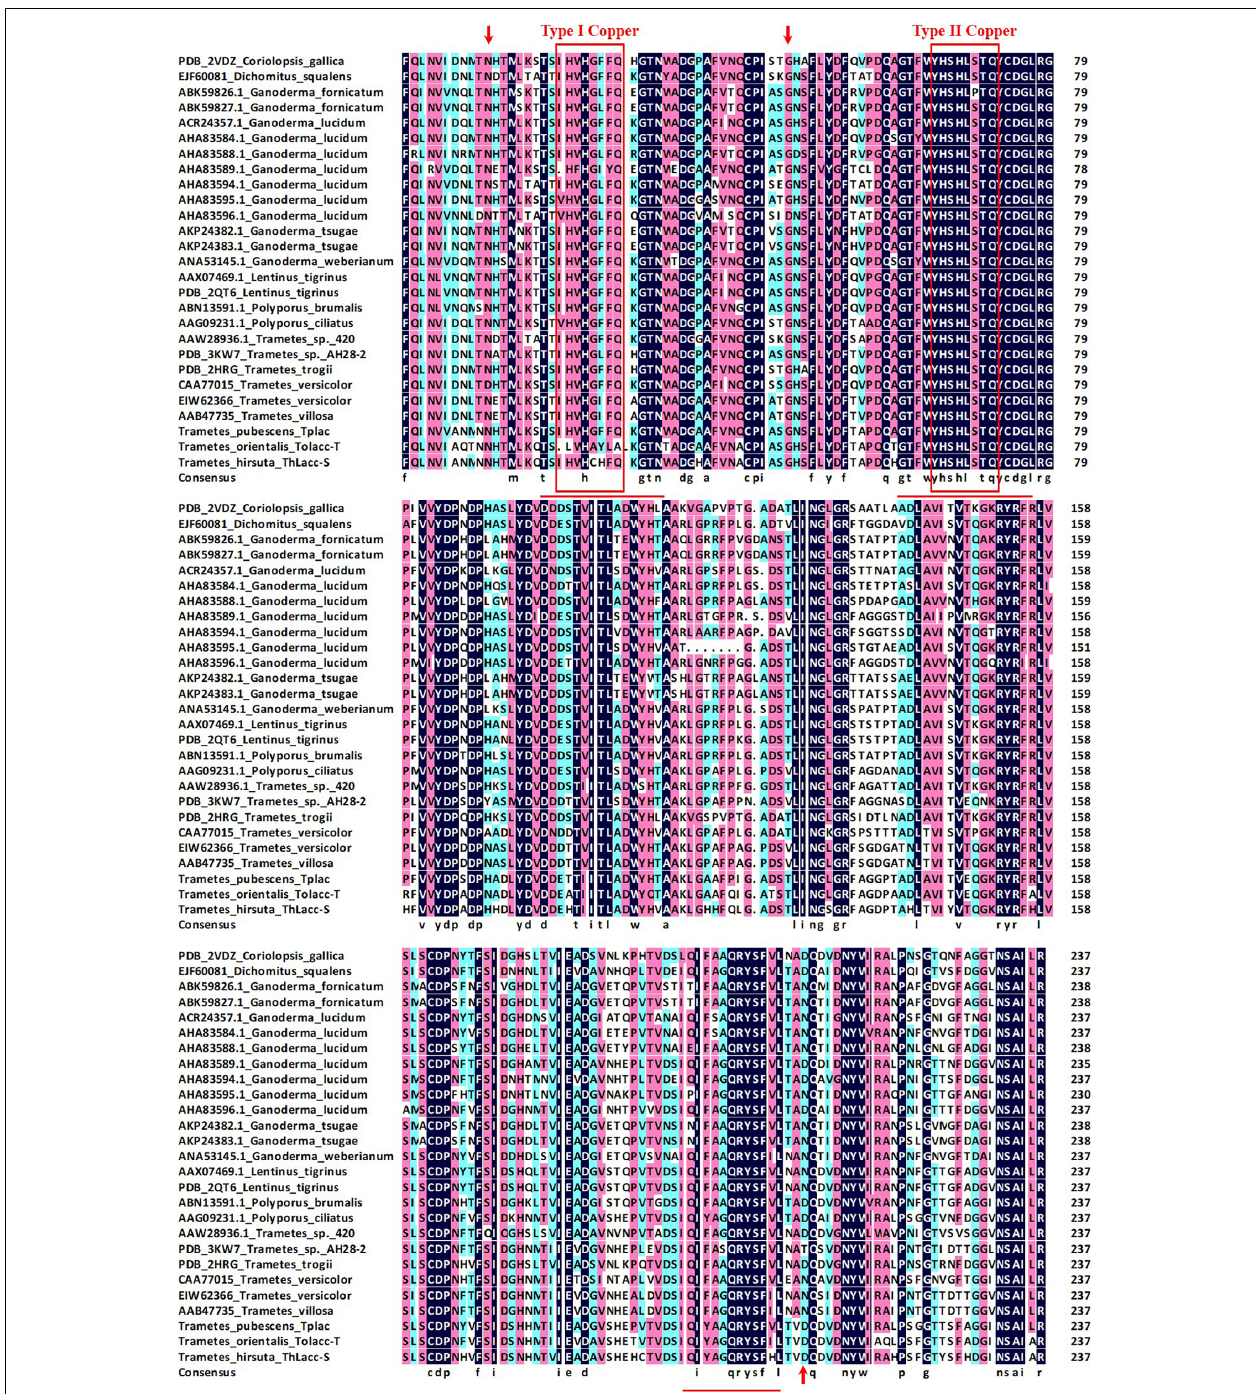
FIGURE 2 | Multiple alignment of the amino acid sequence of laccase ThLacc-S from Trametes hirsuta with those of other fungal laccases including Coriolopsis gallica (PDB: 2VDZ), Dichomitus squalens (EJF60081), Ganoderma fornicatum (ABK59826.1 and ABK59827.1), G. lucidum (ACR24357.1, AHA83584.1, AHA83588.1, AHA83589.1, AHA83594.1, AHA83595.1, and AHA83596.1), G. tsugae (AKP24382.1 and AKP24383.1), G. weberianum (ANA53145.1), Lentinus tigrinus (AAX07469.1 and PDB: 2QT6), Polyporus brumalis (ABN13591.1), P. ciliatus (AAG09231.1), Trametes sp. 420 (AAW28936.1), Trametes sp. AH28-2 (PDB: 3KW7), T. trogii (PDB: 2HRG), T. versicolor (CAA77015 and EIW62366), T. villosa (AAB47735), T. pubescens Tplac, and T. orientalis Tolacc-T. Numbers on the right are the positions of the final amino acids in each line. Residues assumed to be involved in binding to copper are boxed in red and residues identical in all 27 sequences are highlighted with a black background. Potential glycosylation sites are indicated with red arrows. Underlined residues indicate the sequences generated through MALDI-TOF MS.